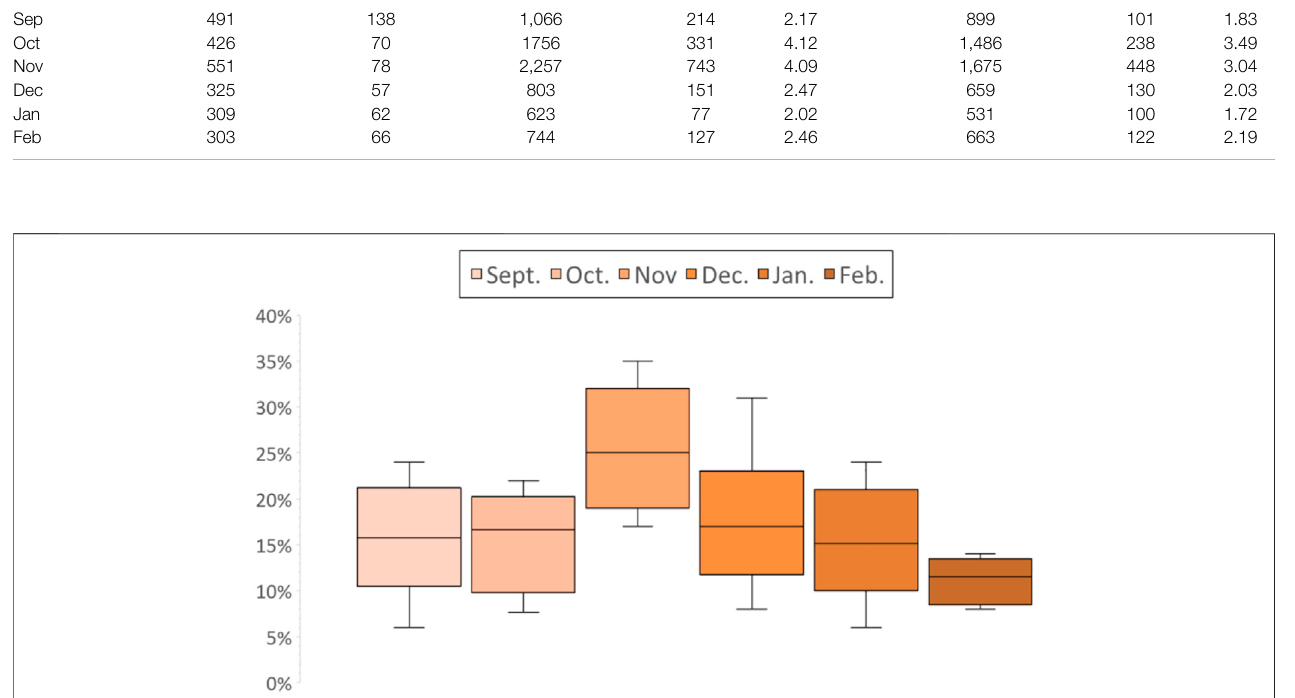
TABLE 3 | Average concentration ( ± SD) concentration of culturable bacteria colony-forming units per cubic meter of air (CFU/m 3 ) inside nursery school during two cycles: when air puri fi er was off (APO)/when air puri fi er was active (APA) and outdoor (OUT). Months OUT APO APA Average concentration SD Average concentration